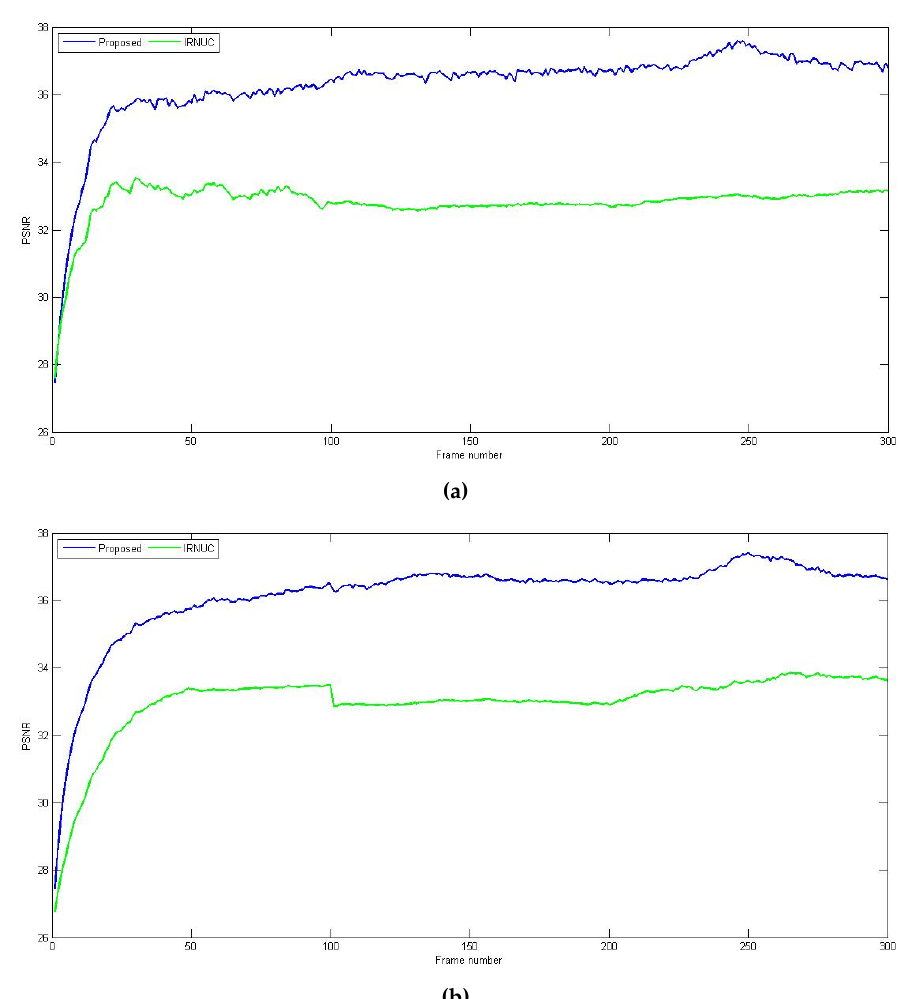
Figure 7. PSNR as a function of the frame number of sequence 2 for the two correction algorithms: Proposed ( Blue ), registration-based ( Green ) ( a ) with the same FPN ( b ) with a simulated drift in the